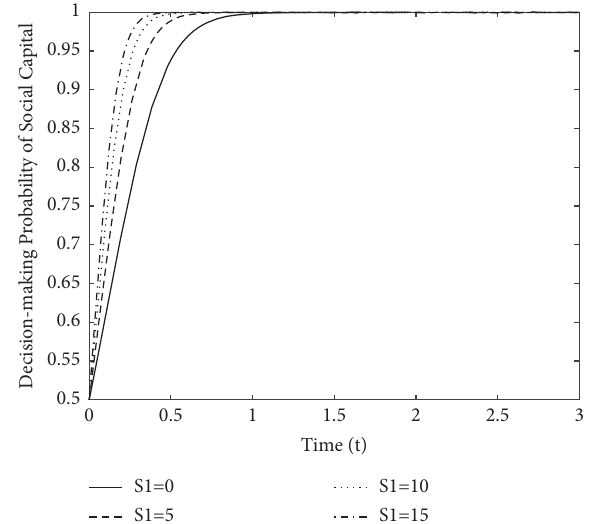
Figure 3: Evolutionary path of S